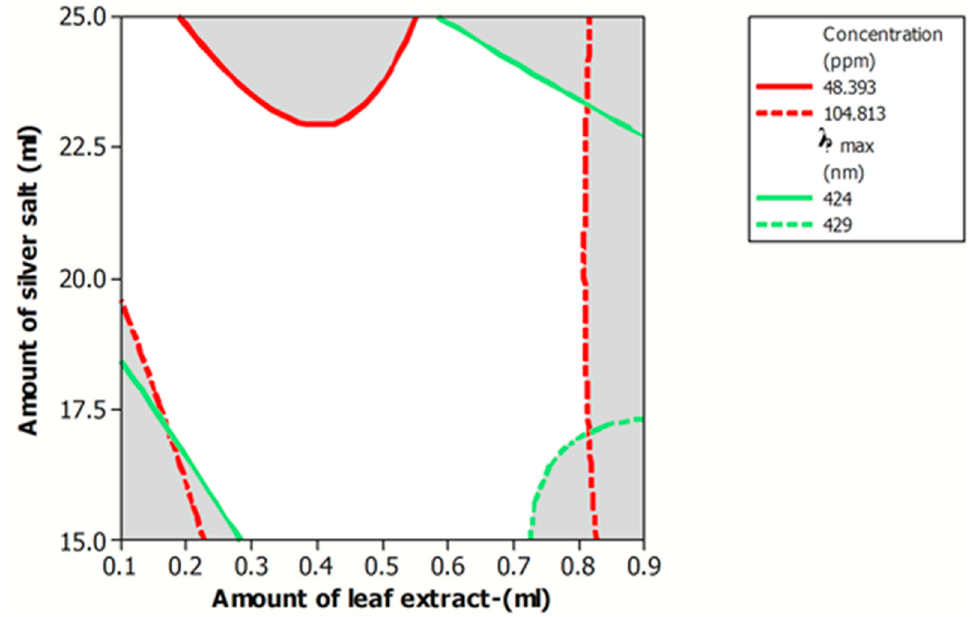
Figure 5. Overlaid contour plot of Ag NPs λ max and concentration with acceptable levels as a function of amount of J. regia leaf extract and amount of AgNO 3 solution.